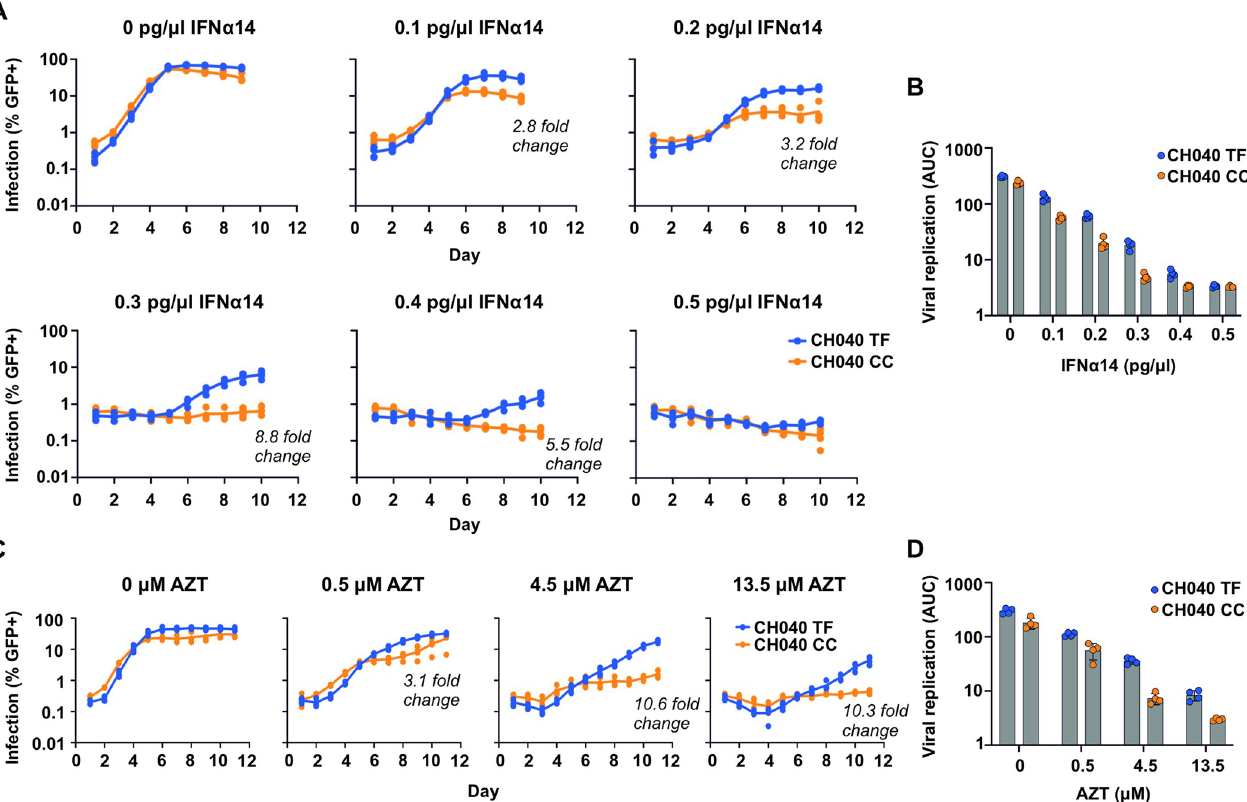
Fig 7. Transmitted HIV-1 of the CH040 virus pair is more resistant to IFN and AZT than the matched chronic virus. (A-B) TMZR5 cells were treated with indicated doses of IFN α 14 for 24 hours before being challenged with the CH040 TF and CC viruses. Cells were sampled daily to monitor virus spread and GFP- positive cells were enumerated via flow cytometry. (C-D) TMZR5 cells were pre-treated with a range of azidothymidine (AZT) doses for 2 hours prior to infection with the CH040 TF or CC viruses. Cells were sampled daily to monitor virus spread and GFP-positive cells were quantified via flow